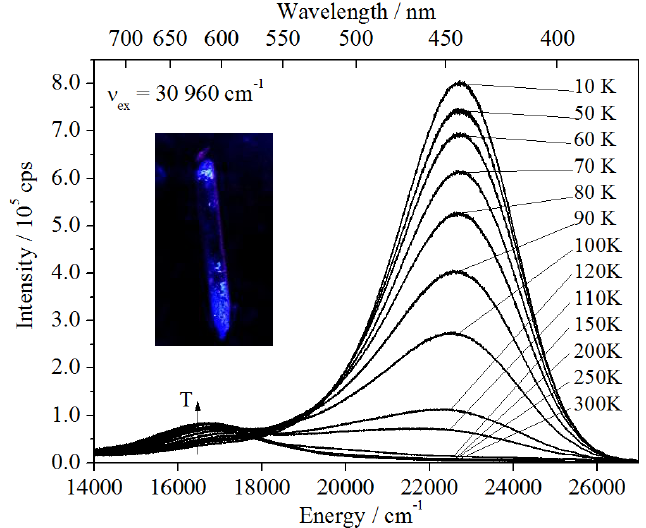
Figure 8. Temperature dependent emission of Ba 22,760 cm −1 and increasing maximum at 16,690 cm −1 for higher temperatures. Inset: Ba SiO :Sr 2+ NPs under UV light, cooled down with liquid N 2 4